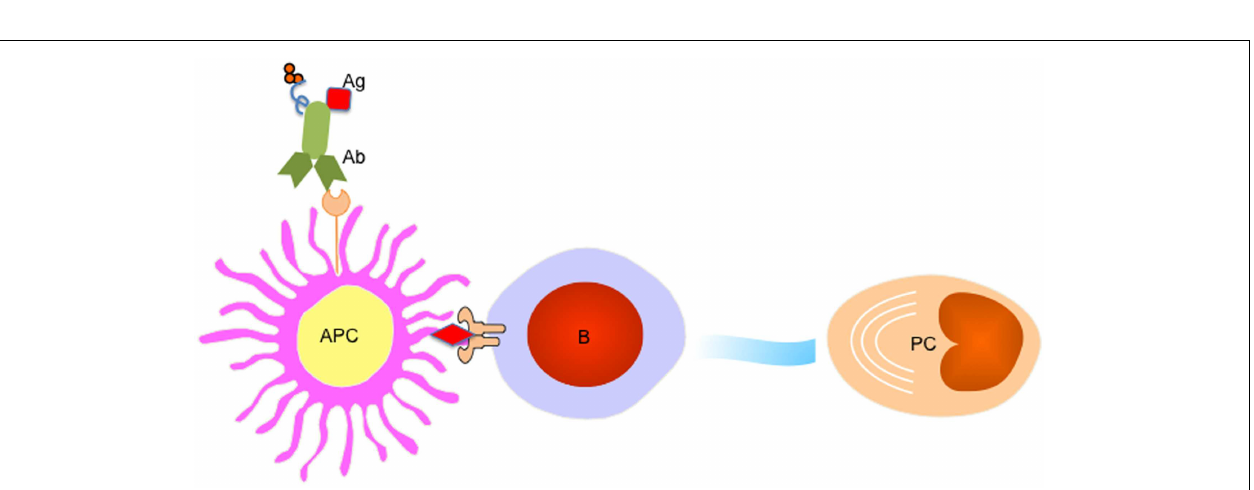
FIGURE 3 |TargetingAPC subsets for a better vaccine for humoral immunity . A fusion protein of Ab (recognizing a particular receptor on APC subset) and Ag complex facilitates Ag uptake by targeted APC subset, which